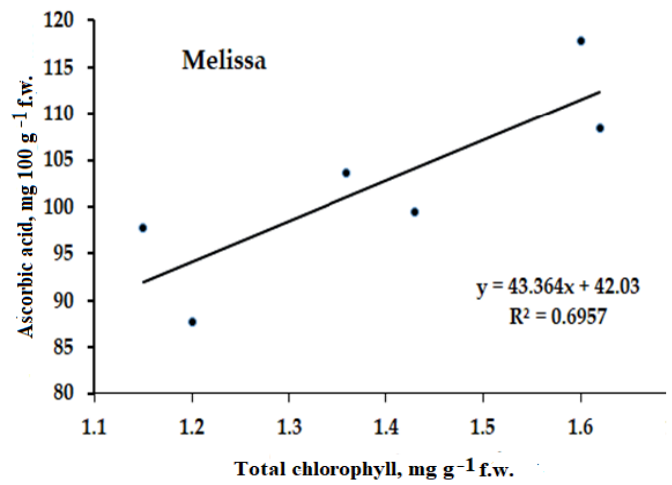
Figure 6. Correlation between ascorbic acid and chlorophyll content in the Savoy cabbage leaves. Vertu 1340: r = 0.89 ( p < 0.005), Golubtsy: r = 0.85 ( p < 0.01), Melissa: r = 0.83 ( p < 0.01). According to the present results, the coefficient of correlation between the ascorbic acid content in leaves and the total Savoy cabbage biomass was 0.559 ( p < 0.03).